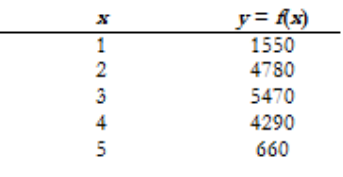
Figure 2. Excerpt from instructions and reading guide for the numerical integration